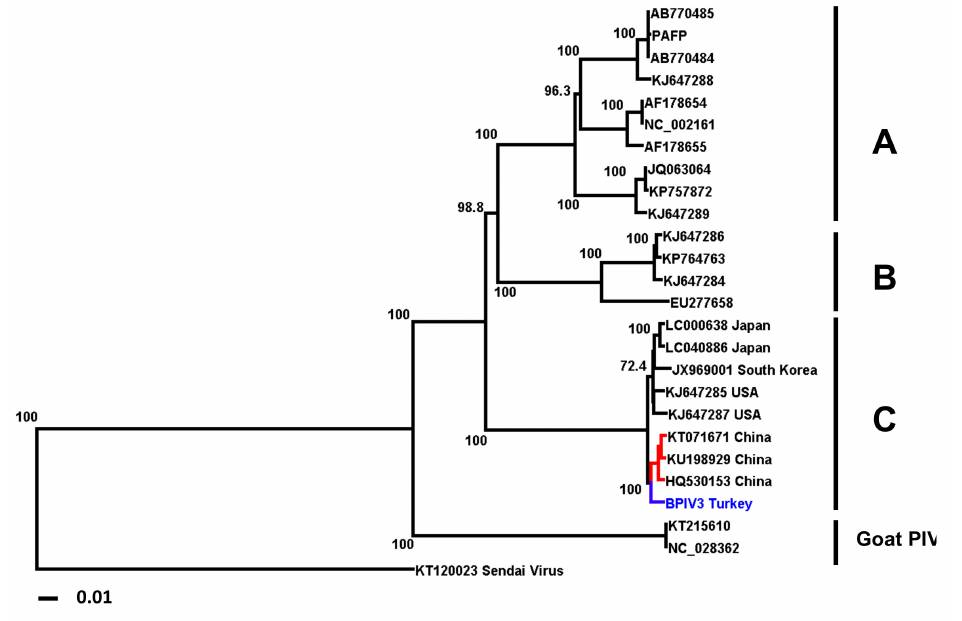
Figure 2. Phylogenetic tree of published full genome sequences of BPIV-3 strains. Strains are identified by their accession numbers. High bootstrap values are indicated. The Turkish isolate is highlighted in blue (Genebank accession no. MH357343). Chinese isolates are highlighted in